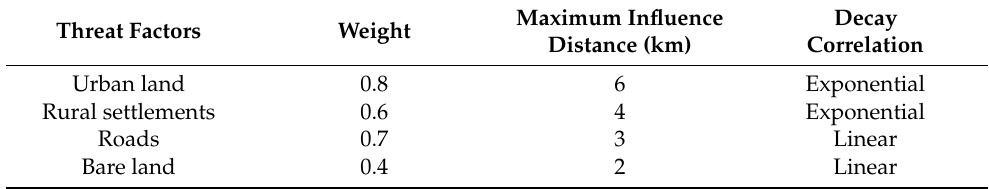
Table 2. Attributes of threat